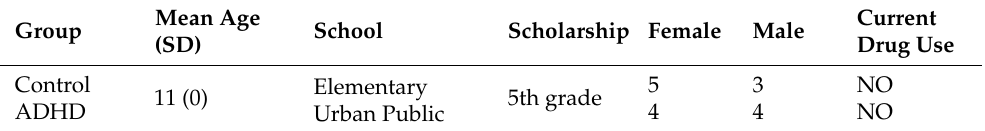
Table 1. Socio-demographic